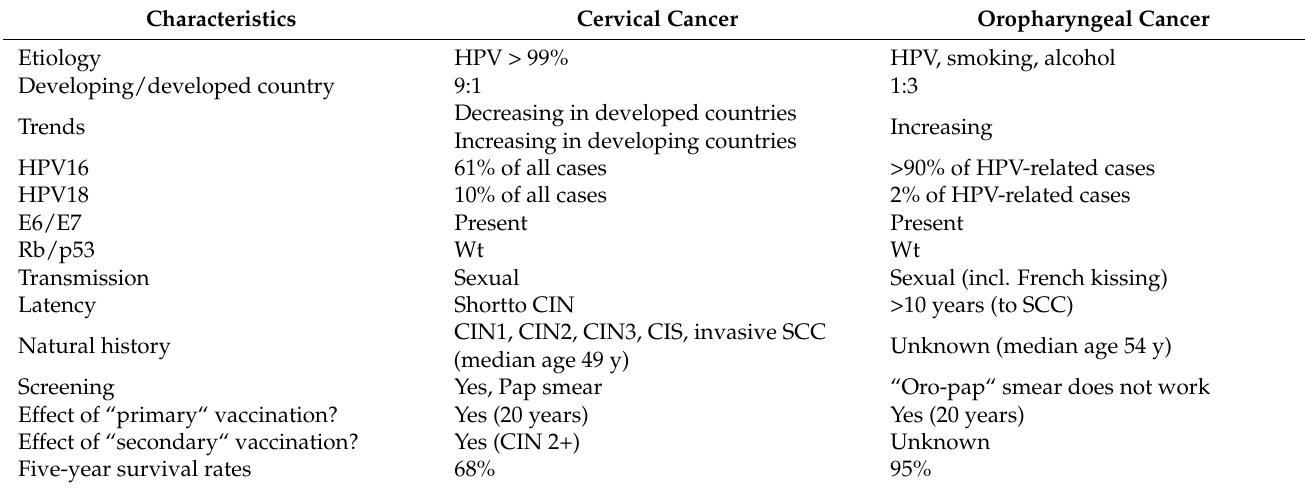
Table 1. Comparison of cervical and oropharyngeal HPV+